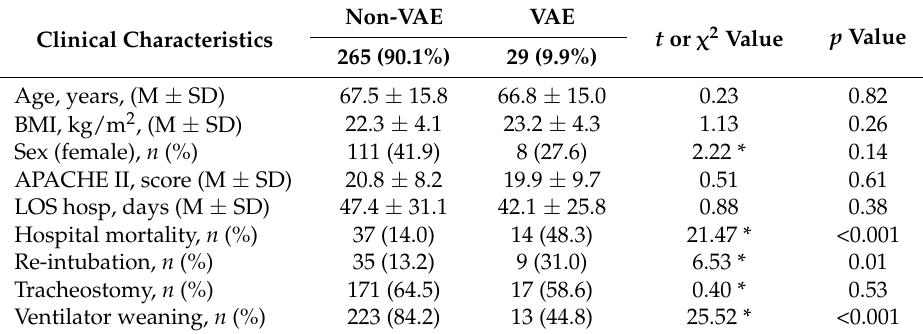
Clinical Characteristics Table 2. Characteristics and outcomes of the non-VAE and VAE groups.